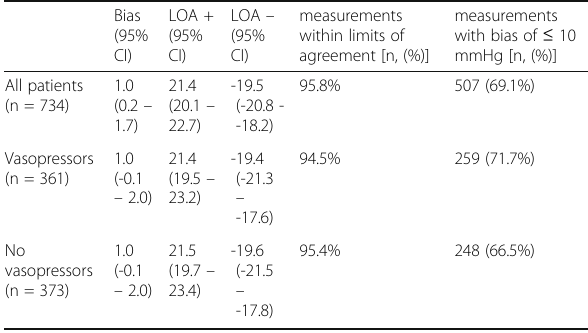
Table 1 (abstract 000895). See text for